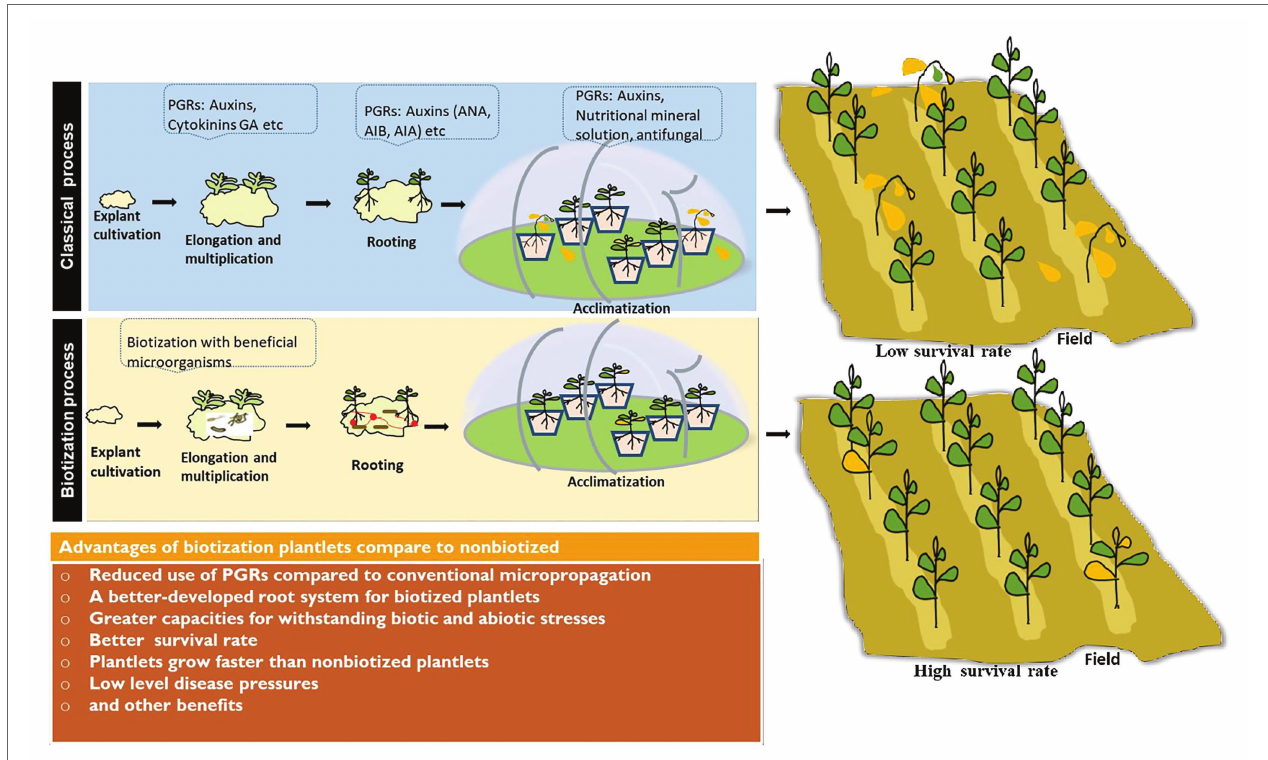
FIGURE 4 | Schematic summary of some benefits of biotization process compared to classical micropropagation